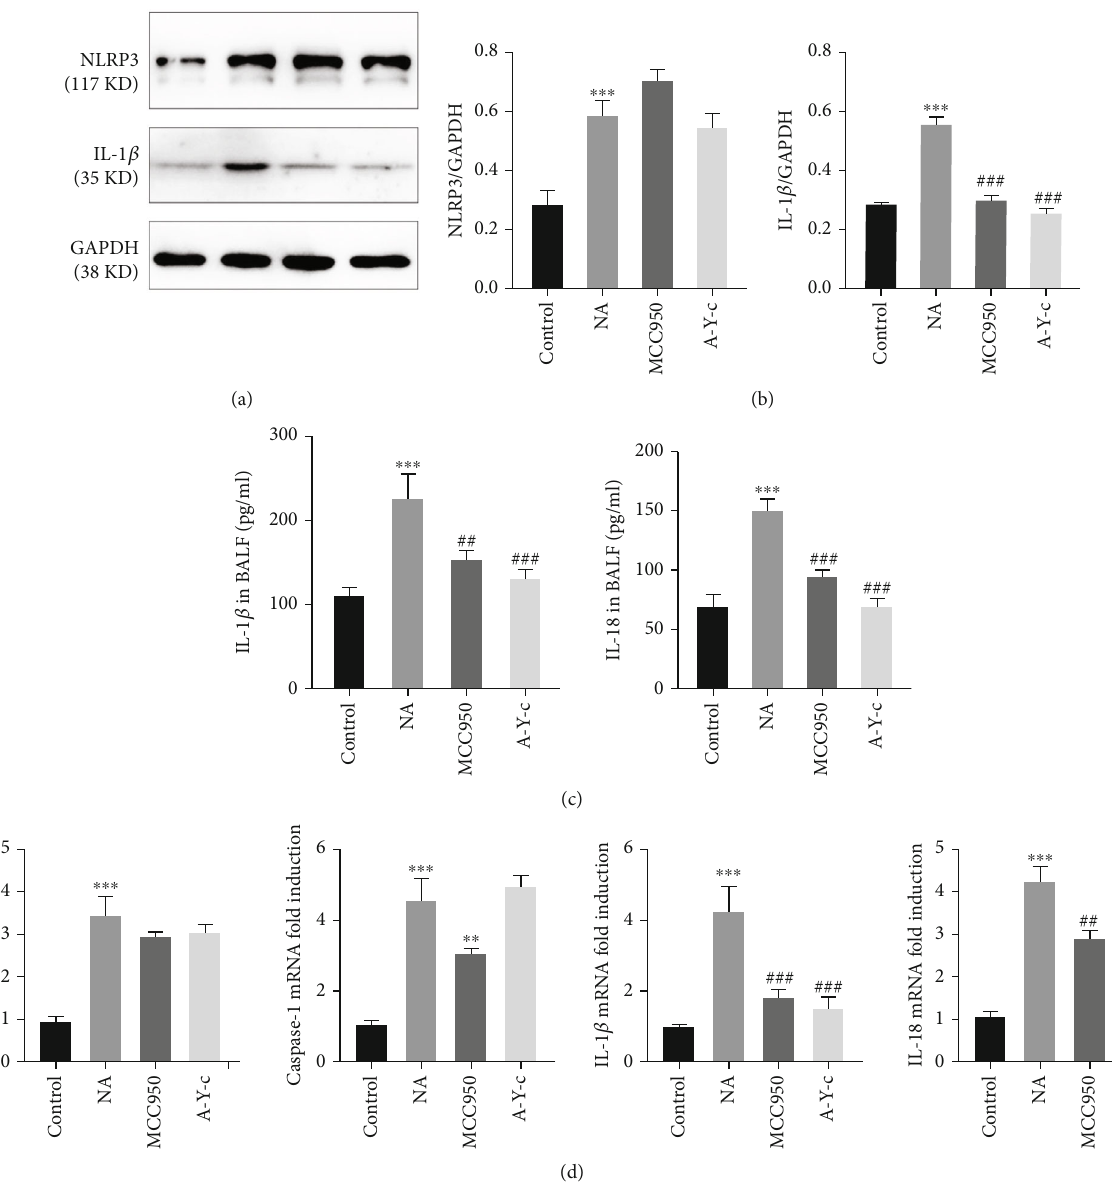
Figure 3: NLRP3/caspase-1 inhibitor downregulated in fl ammasome activation and downstream factors. (a, b) Protein expression of NLRP3 (117KD) and IL-1 β (35 KD) in lung homogenates was detected by western blot, and densitometric analysis was performed. (c) The concentration of IL-1 β and IL-18 in BALF was quanti fi ed by ELISA. (d) mRNA expression of Nlrp3, caspase-1, IL-1 β , and IL-18 in lung homogenates was detected by real-time PCR. Data are expressed as mean ± SEM . n = 6 . Compared to the control group, ∗ p < 0 : 05 , ∗∗ p < 0 : 01 , and ∗∗∗ p < 0 : 001 ; compared to the neutrophilic asthma group, # p < 0 : 05 , ## p < 0 : 01 , and ### p < 0 : 001 . NLRP3: nucleotide-binding oligomerization domain-like receptor family pyrin domain containing 3; BALF: bronchoalveolar lavage fl uid; ELISA: enzyme-linked immunosorbent assay; PCR: polymerase chain